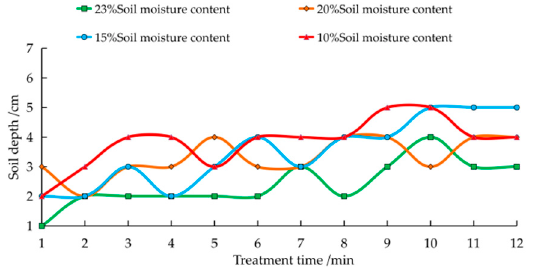
Figure 36. The maximum temperature ⎯ Tmax of the loess internal test point.